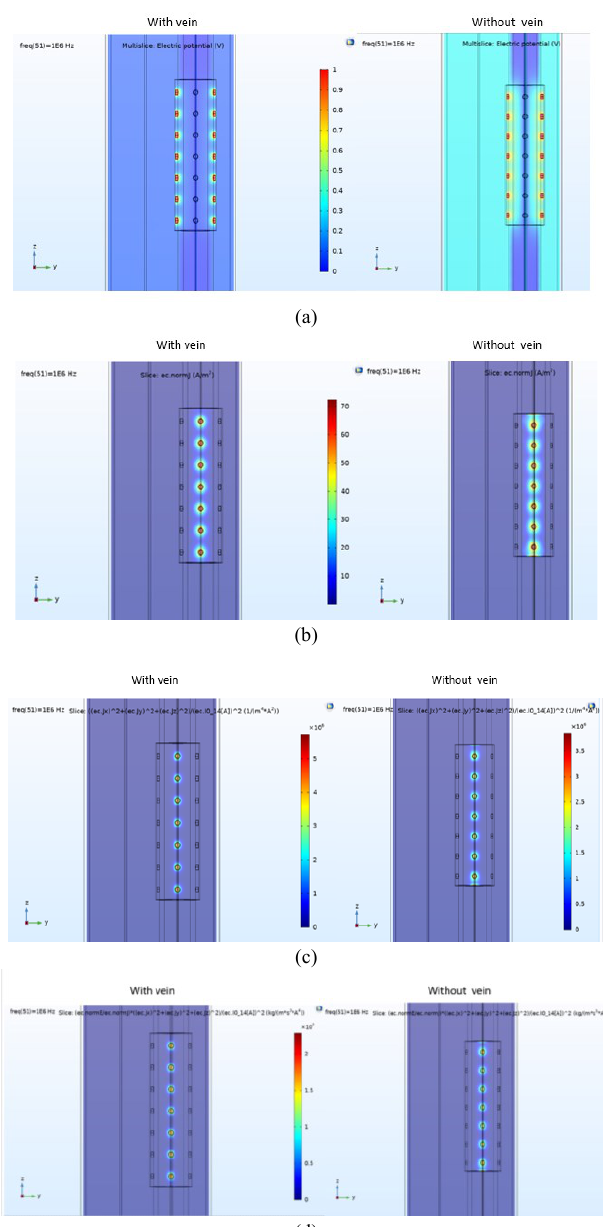
Figure 3: Diagram of the complex impedance illustrating the relationship between the real and imaginary parts of the impedance, where Z real is the real or resistive component R of the impedance, whereas Z imag is the imaginary or capacitive X component. |Z| and ϕ define the impedance magnitude and phase shift respectively.